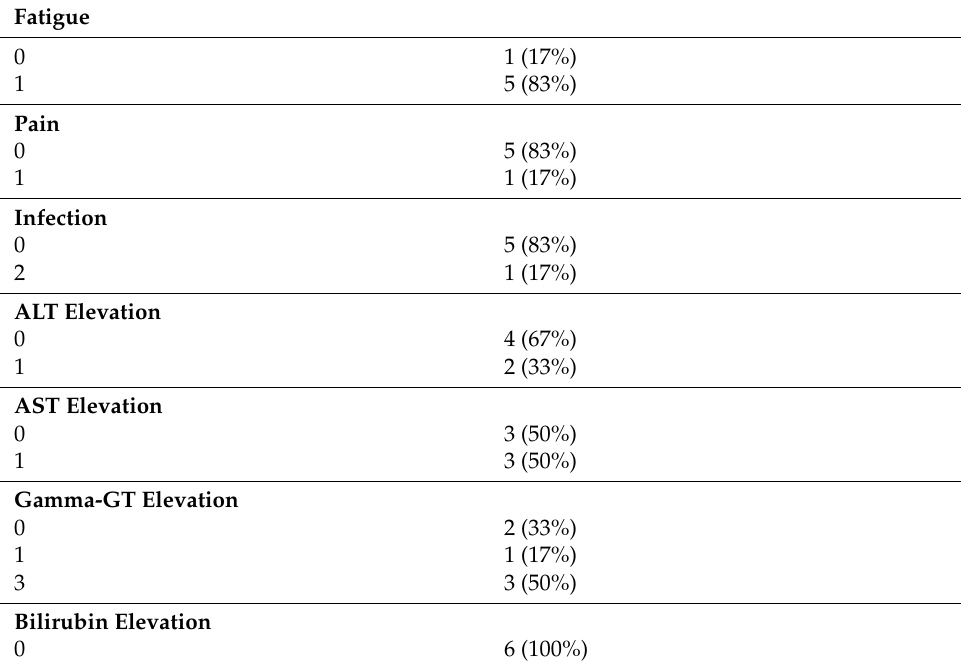
Table 4. Maximum grade toxicity (CTCAE v4.03) at baseline.